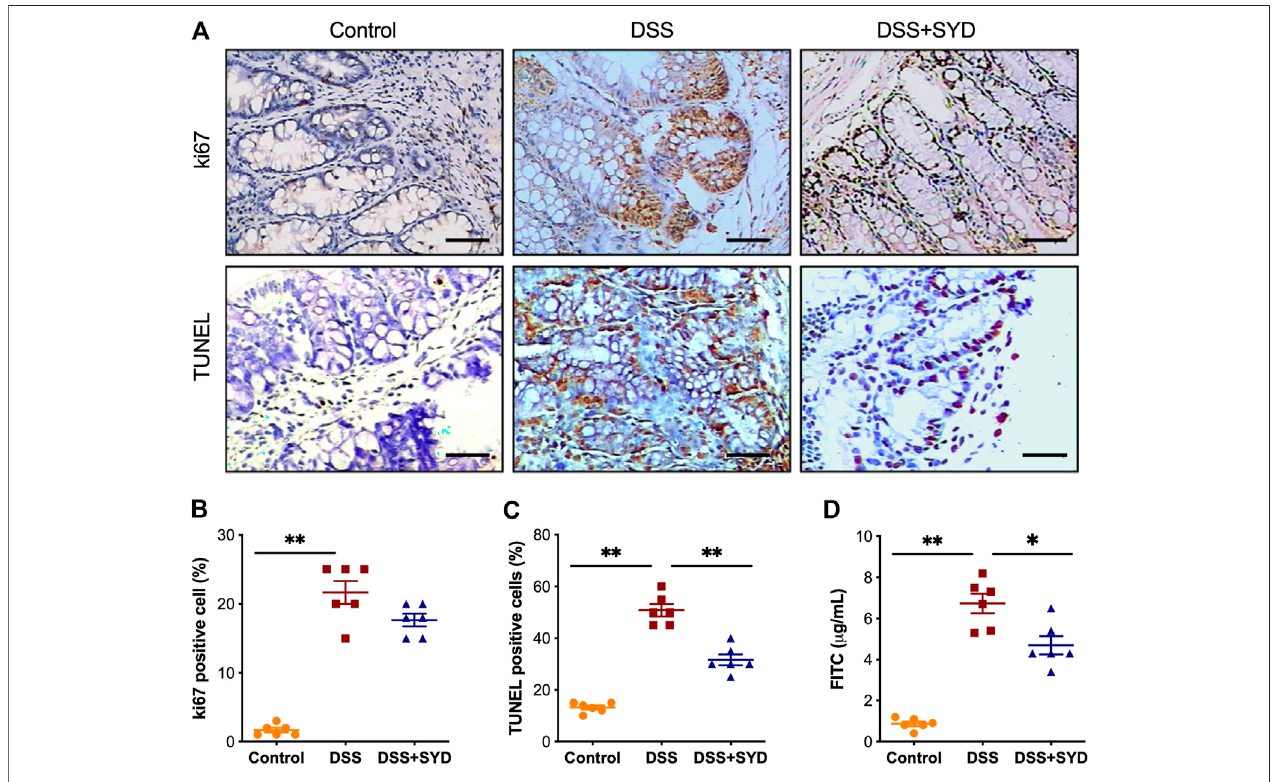
FIGURE 5 | SYD regulates the proliferation and apoptosis of colonic enterocytes and intestinal epithelial permeability in DSS-induced colitis mice (A) Immunohistochemical analysis of proliferating cells detected based on Ki67 expression in colon sections and TUNEL assays for apoptosis. Scale bars (cid:2) 100 μ m (B) Percentage of Ki67-positive cells (C) Percentage of TUNEL-positive cells (D) Mice received oral gavage of FITC-dextran (0.6 mg/g), and serum FITC-dextran concentrations were determined 4 h later. Data are presented as the mean ± SEM, n (cid:2) 6 per group. * p < 0.05, ** p <